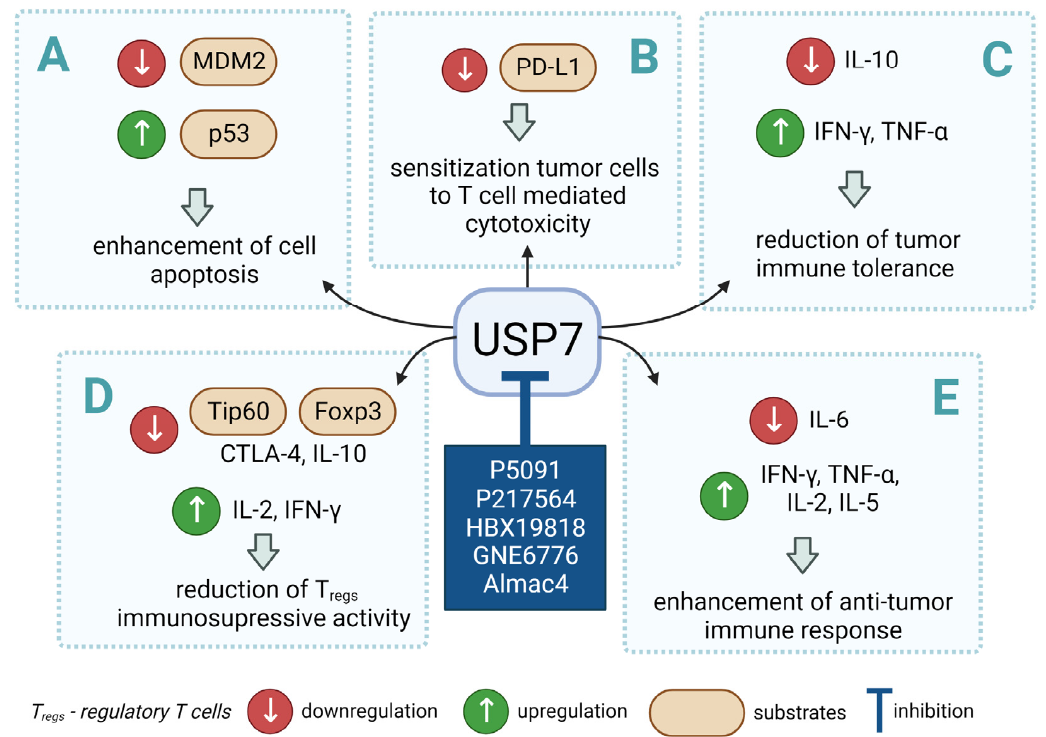
Figure 2. Small molecule inhibition of USP7 and its effect on anti-tumor immune response: ( A ) Ini- tiation of p53-dependent apoptosis in tumor cells via p53/MDM2 pathway. ( B ) Decreasing PD-L1 levels sensitize tumor cells to T cell-mediated cytotoxicity by reducing PD-L1 interaction with PD-1. ( C ) Overcoming the immune tolerance of tumor via lowering IL-10 levels. ( D ) Reducing immunosup- pressive functions of Tregs via destabilization of Tip60 and Foxp3. ( E ) Promotion of local anti-tumor immune response in tumor microenvironment via polarization of macrophage phenotype from anti-inflammatory M2 to proinflammatory M1.